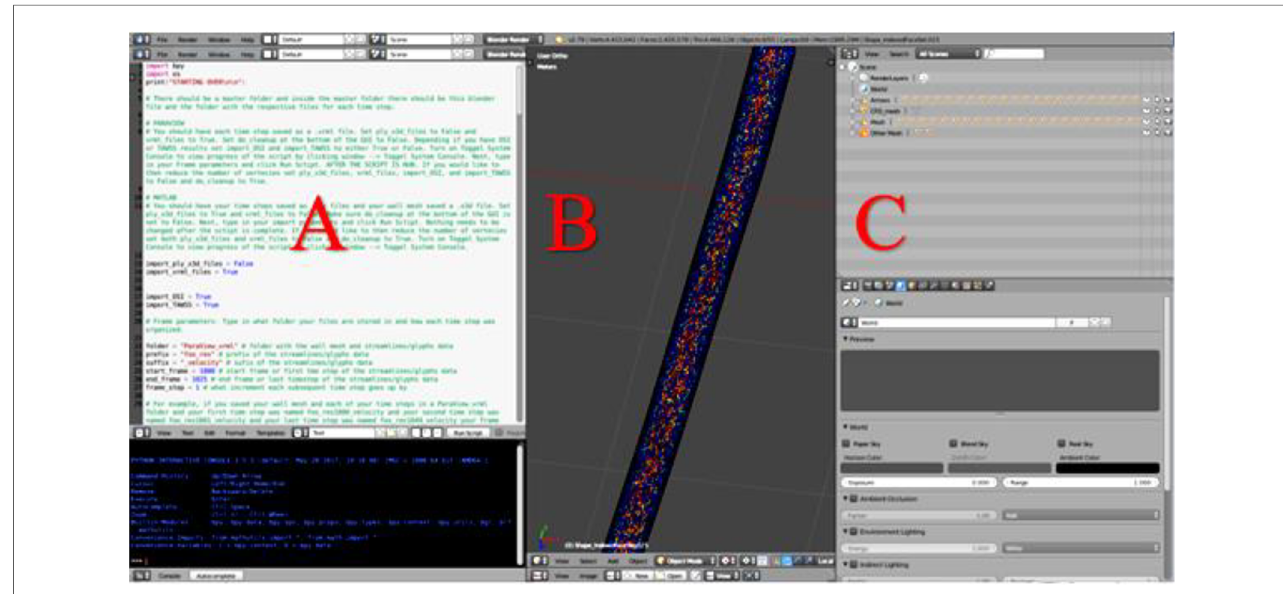
FIGURE 2 Screenshot of Blender ’ s interface depicting CFD simulation details from a cylinder phantom. ( A ) Blender ’ s Text Editor where a Python script is used to reorganize the simulation details and reduce the number of vertices. ( B ) Blender ’ s 3D View which displays every object of the simulation. Objects will be turned on or off within Unity as part of a later step, and ( C ) Blender ’ s Outliner of parent-child relationships where each object may be